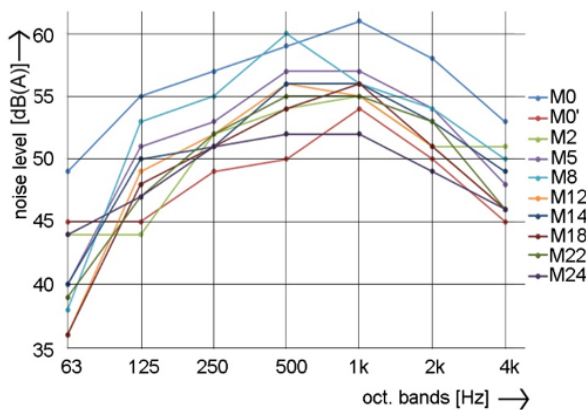
Figure 13: Frequency spectrum of measured road traflc noise along the façade of ‘’Apollon”. M0: reference point , M0’, 2nd, etc.: test